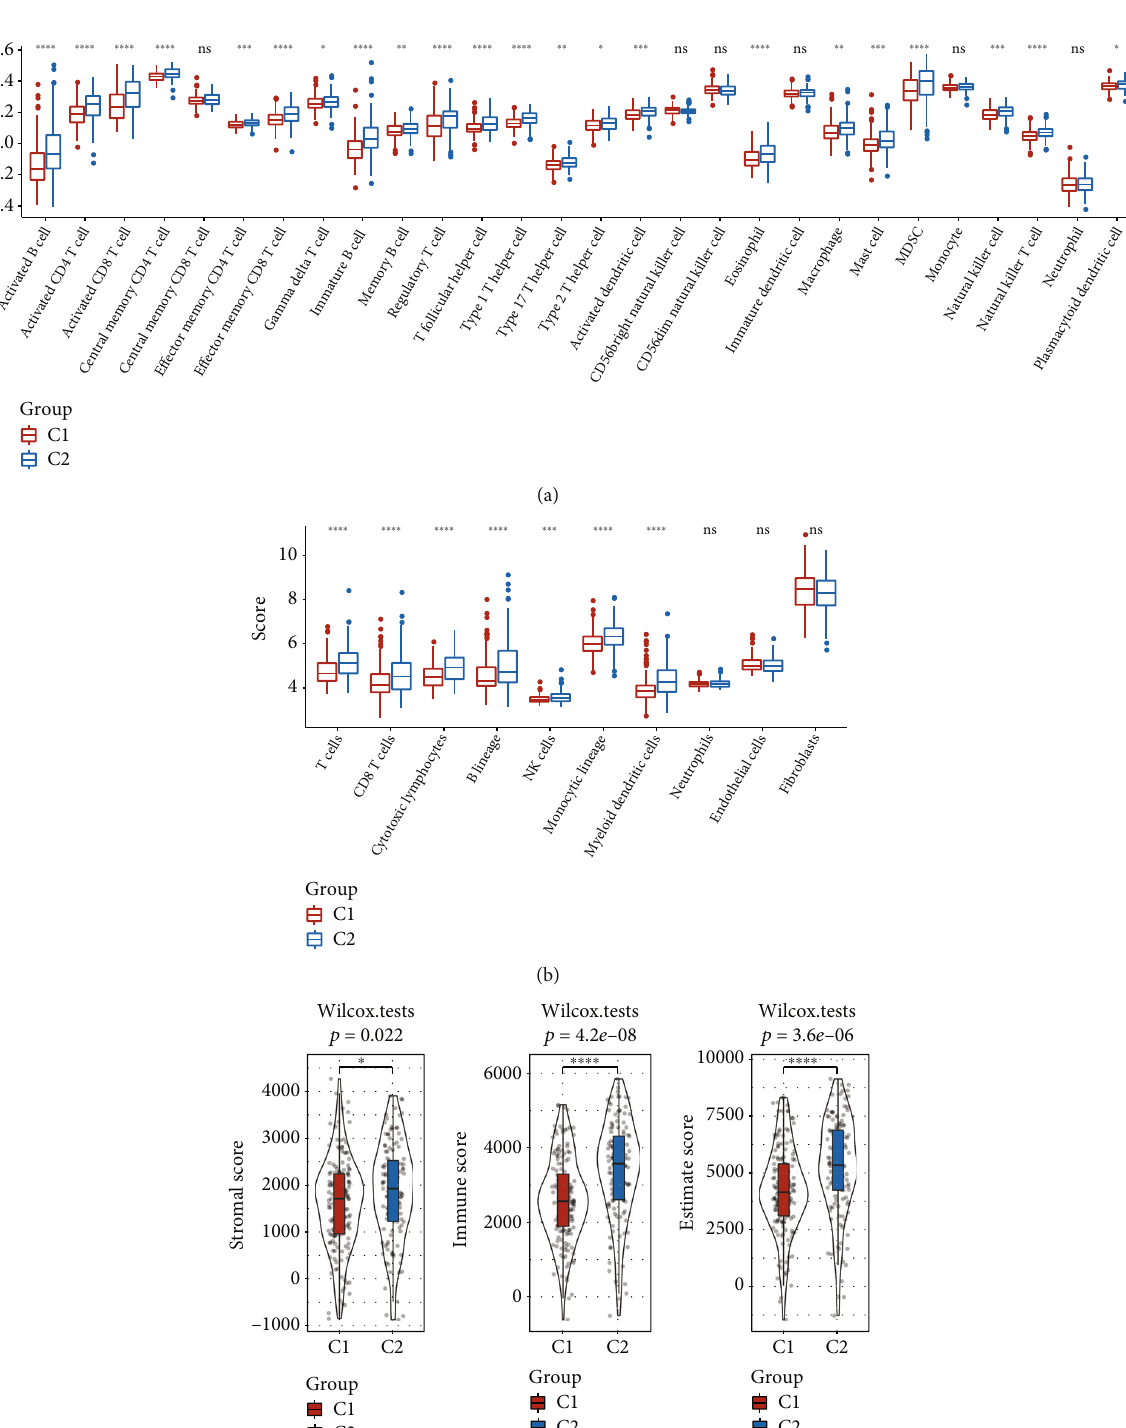
Figure 2: Immune-based properties of the 2 molecular subtypes in the RNAseq data set. (a) ssGSEA compared the 28 immune cell scores in the 2 subtypes. (b) MCP-Counter compared the 10 immune cell scores in the 2 subtypes. (c) ESTIMATE compared the StromalScore values in the 2 subtypes. (d) ESTIMATE compared the ImmuneScore values in the 2 subtypes. (e) ESTIMATE compared the ESTIMATEScore values in the 2